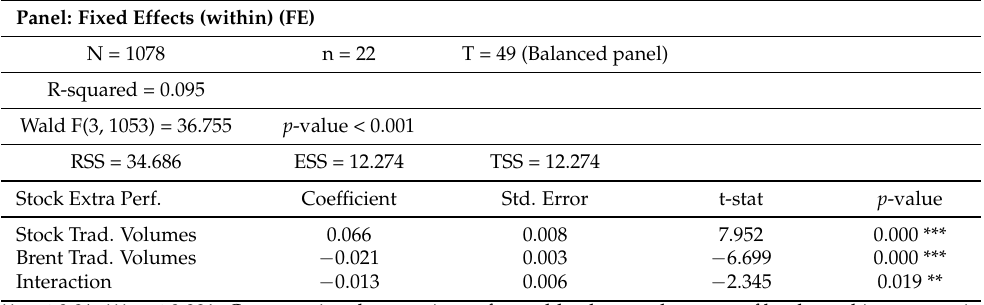
Table 6. Relationship between extra return, oil and trading volumes during the COVID-19 pandemic. Panel: Fixed effects (within) (FE) N = 550 n = 22 T = 25 (Balanced panel) R-squared = 0.088 Wald F(3, 525) = 16.949 p -value = 0.000 RSS = 6.402 ESS = 6.264 TSS = 6.264 Stock Extra Perf. Coefficient Std. Error t-stat p -value Stock Trad. Volumes 0.010465 0.006042 1.7319 0.084 * Brent Trad. Volumes − 0.01471 0.002449 − 6.0084 0 *** Interaction − 0.00558 0.002057 − 2.711 0.007